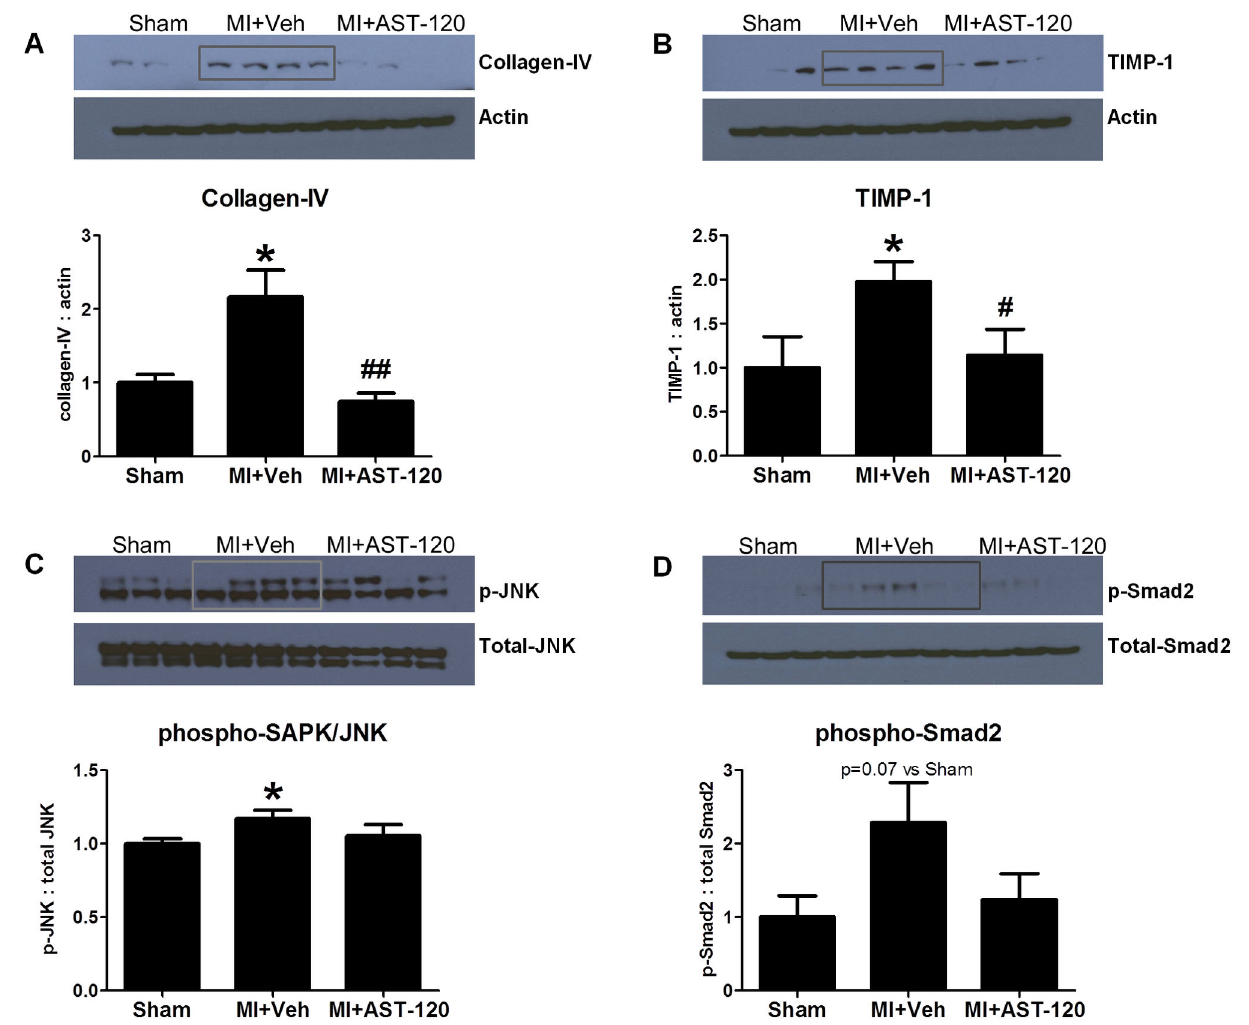
Figure 3. Renal protein expression. MI+Vehicle animals significantly increased renal protein expression of collagen-IV, TIMP-1 and phospho-SAPK/JNK (A, B, C) and a trend toward an increase in renal phospho-Smad2 expression (D). AST-120 treatment significantly reduced collagen-IV and TIMP-1 expression (A, B). A trend toward decreased phospho-SAPK/JNK and phospho- Smad2 expression was also observed (C, D). *p<0.05 vs Sham. # p<0.05, ## p<0.01 vs MI+Vehicle.